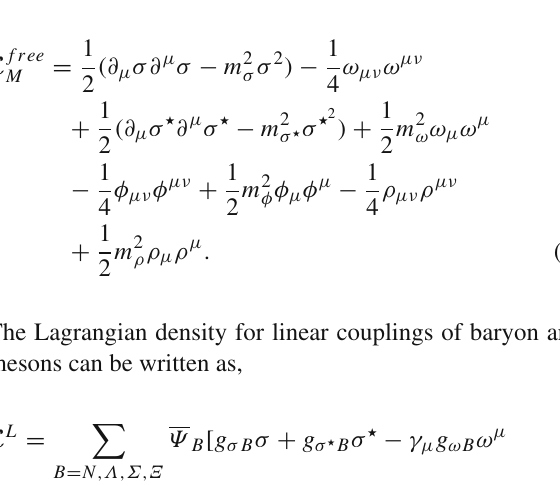
Fig. 1 Mass-radius relationof anisotropic NSs withinDY, HB, and BL models. The results of the isotropic model (I) are given to be compared with the anisotropic model parameters i.e. λ , h , and